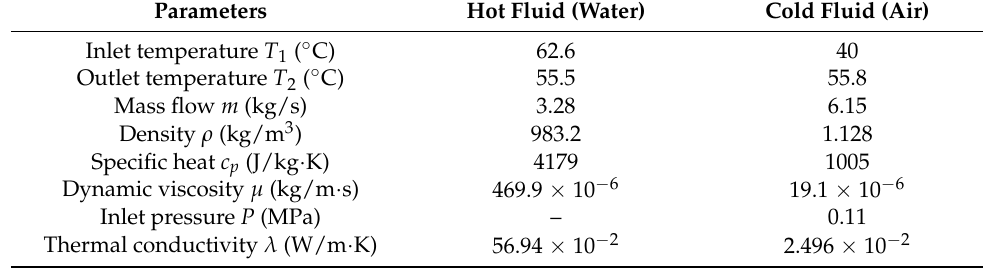
Table 2. Known data of working medium.